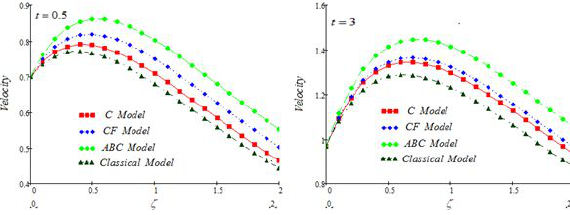
Figure 2: Comparison of velocity for integer & non-integer derivative